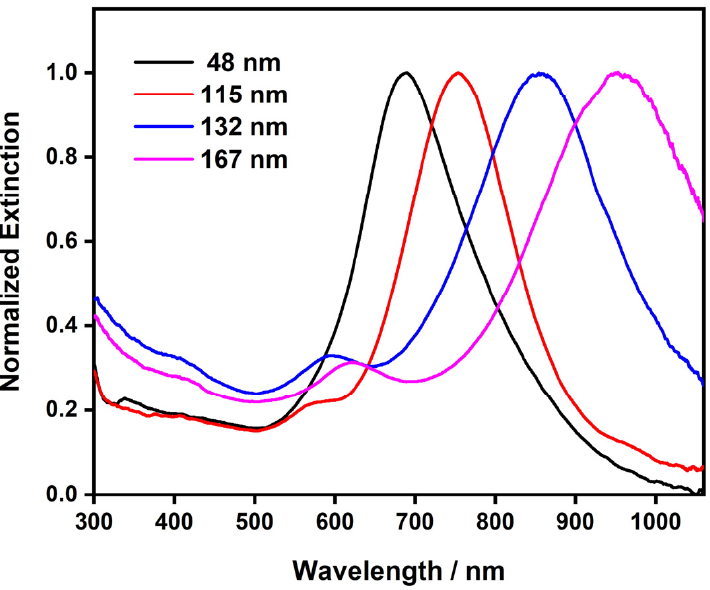
Figure 5. UV–Vis spectra of the Au nanoplates with different edge lengths.